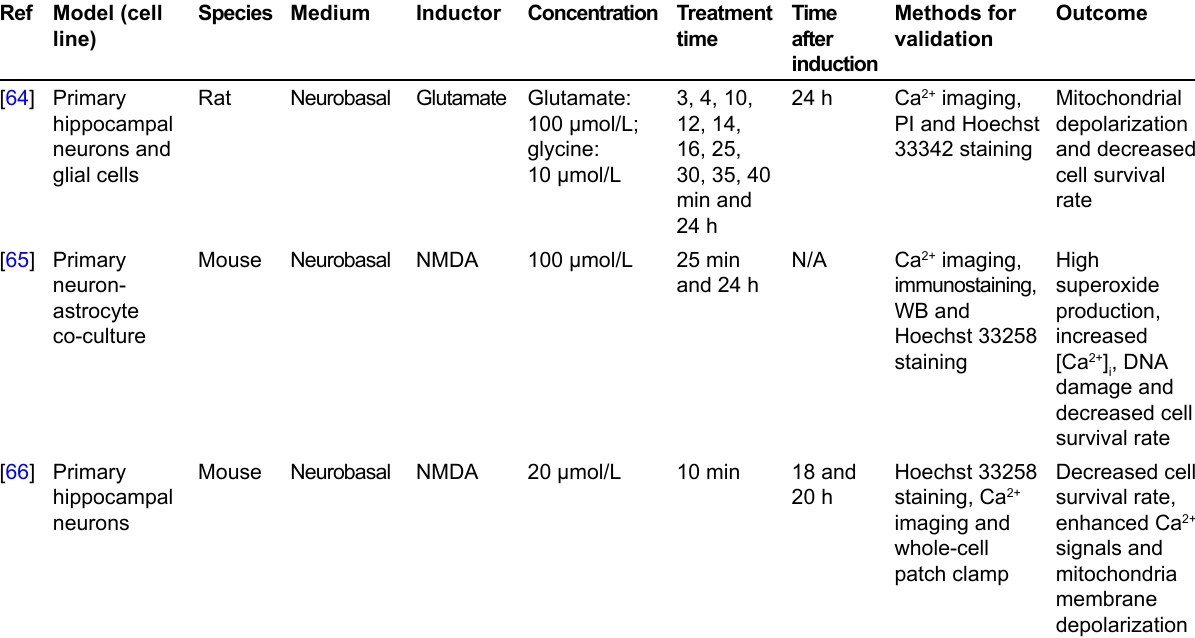
Table 1. Experimental aspects used in published excitotoxicity papers ( continued ) Ref Model